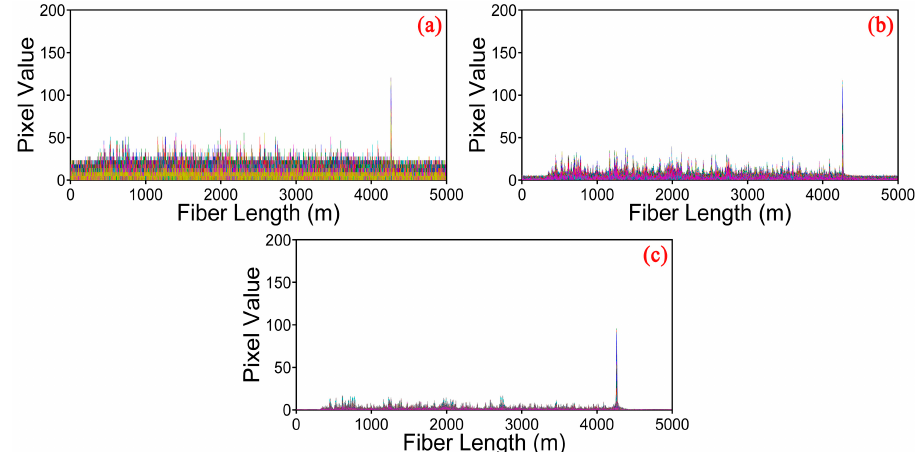
Figure 4. Location information under different methods. ( a ) Moving differential method; ( b ) Curvelet denoising method based on the traditional thresholding; ( c ) Curvelet denoising method based on the optimized thresholding.